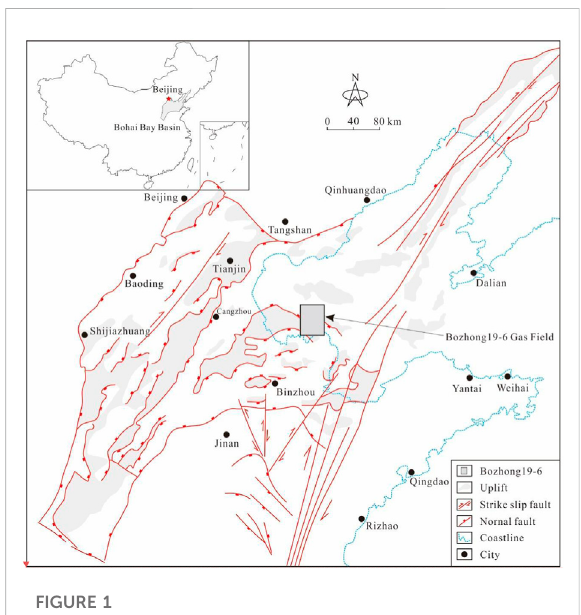
FIGURE 1 Structure location of Bozhong 19-6 Gas Field (Gong et al.,